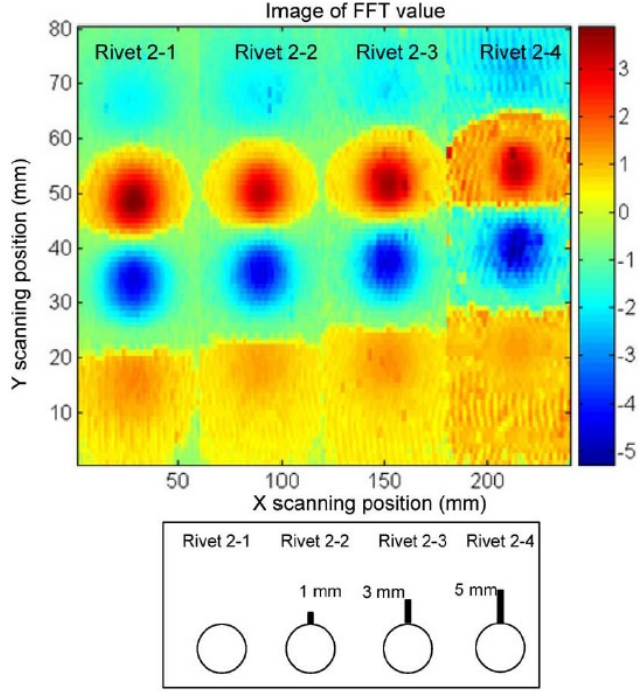
Figure 20. C-scan images derived from the transient GMR signals.